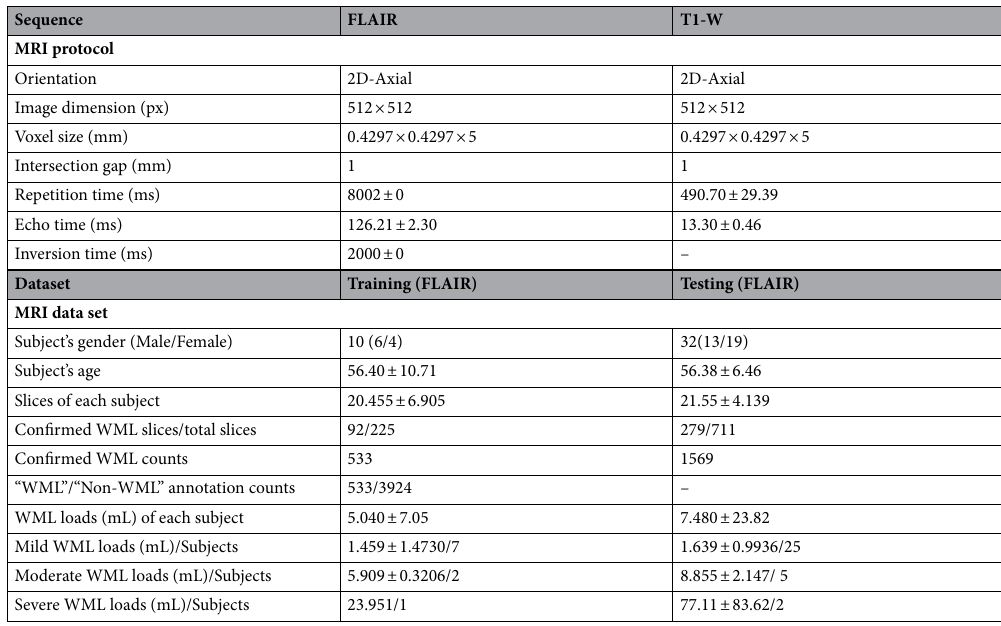
Table 3. MRI protocol specification for the FLAIR and T1-W sequence obtained from a 1.5 T Signa HDx GE Scanner and detailed information about the use of MRI datasets for training and testing. Repetition time, Echo time, Inversion time, Age, Slices of each subject, and WML loads are presented as mean ± standard deviation. ms, mm, and mL represent for milliseconds, millimeters, and milliliters,